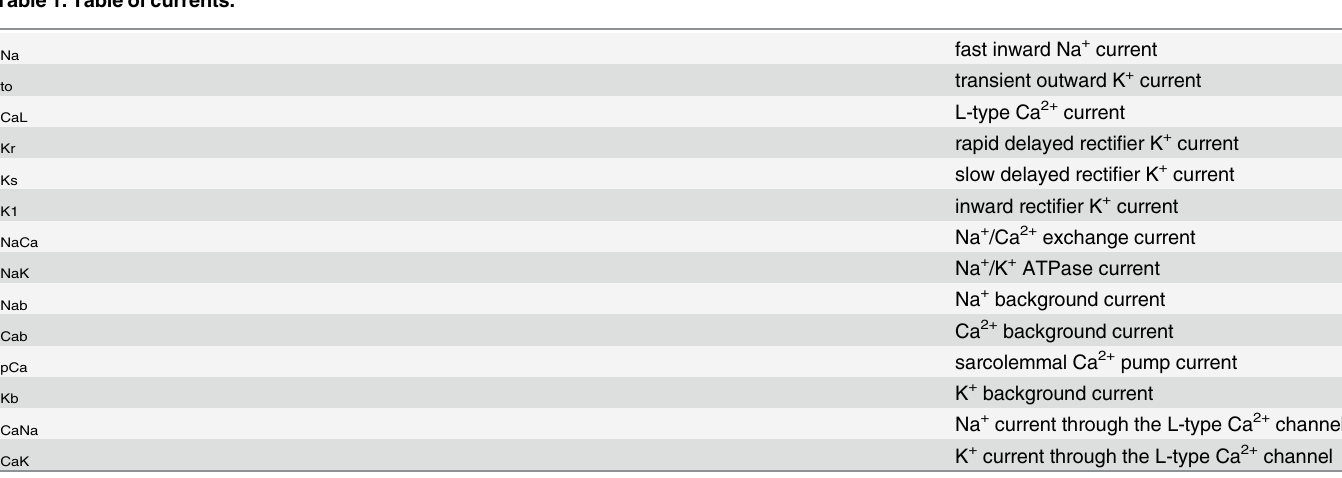
Table 1. Table of currents.